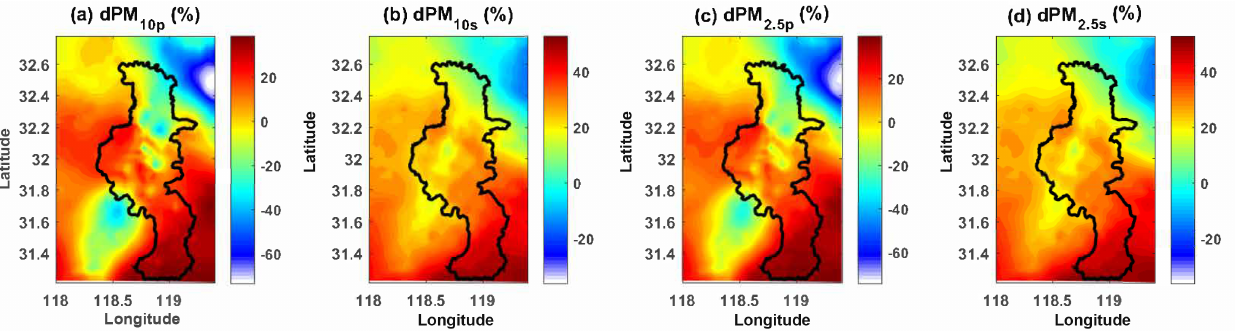
Figure 8. Influence of meteorology on hourly mean concentrations of primary and secondary particulate matter in August 2014 com- pared with August 2013. Black thick lines outline Nanjing. Panels (a–d) are hourly average values of impact percentage (dspecies (%) = (Experiment 2 − Experiment 3) / Experiment 2 × 100%) of PM 10p , PM 10s , PM 2 . 5p and PM 2 . 5s